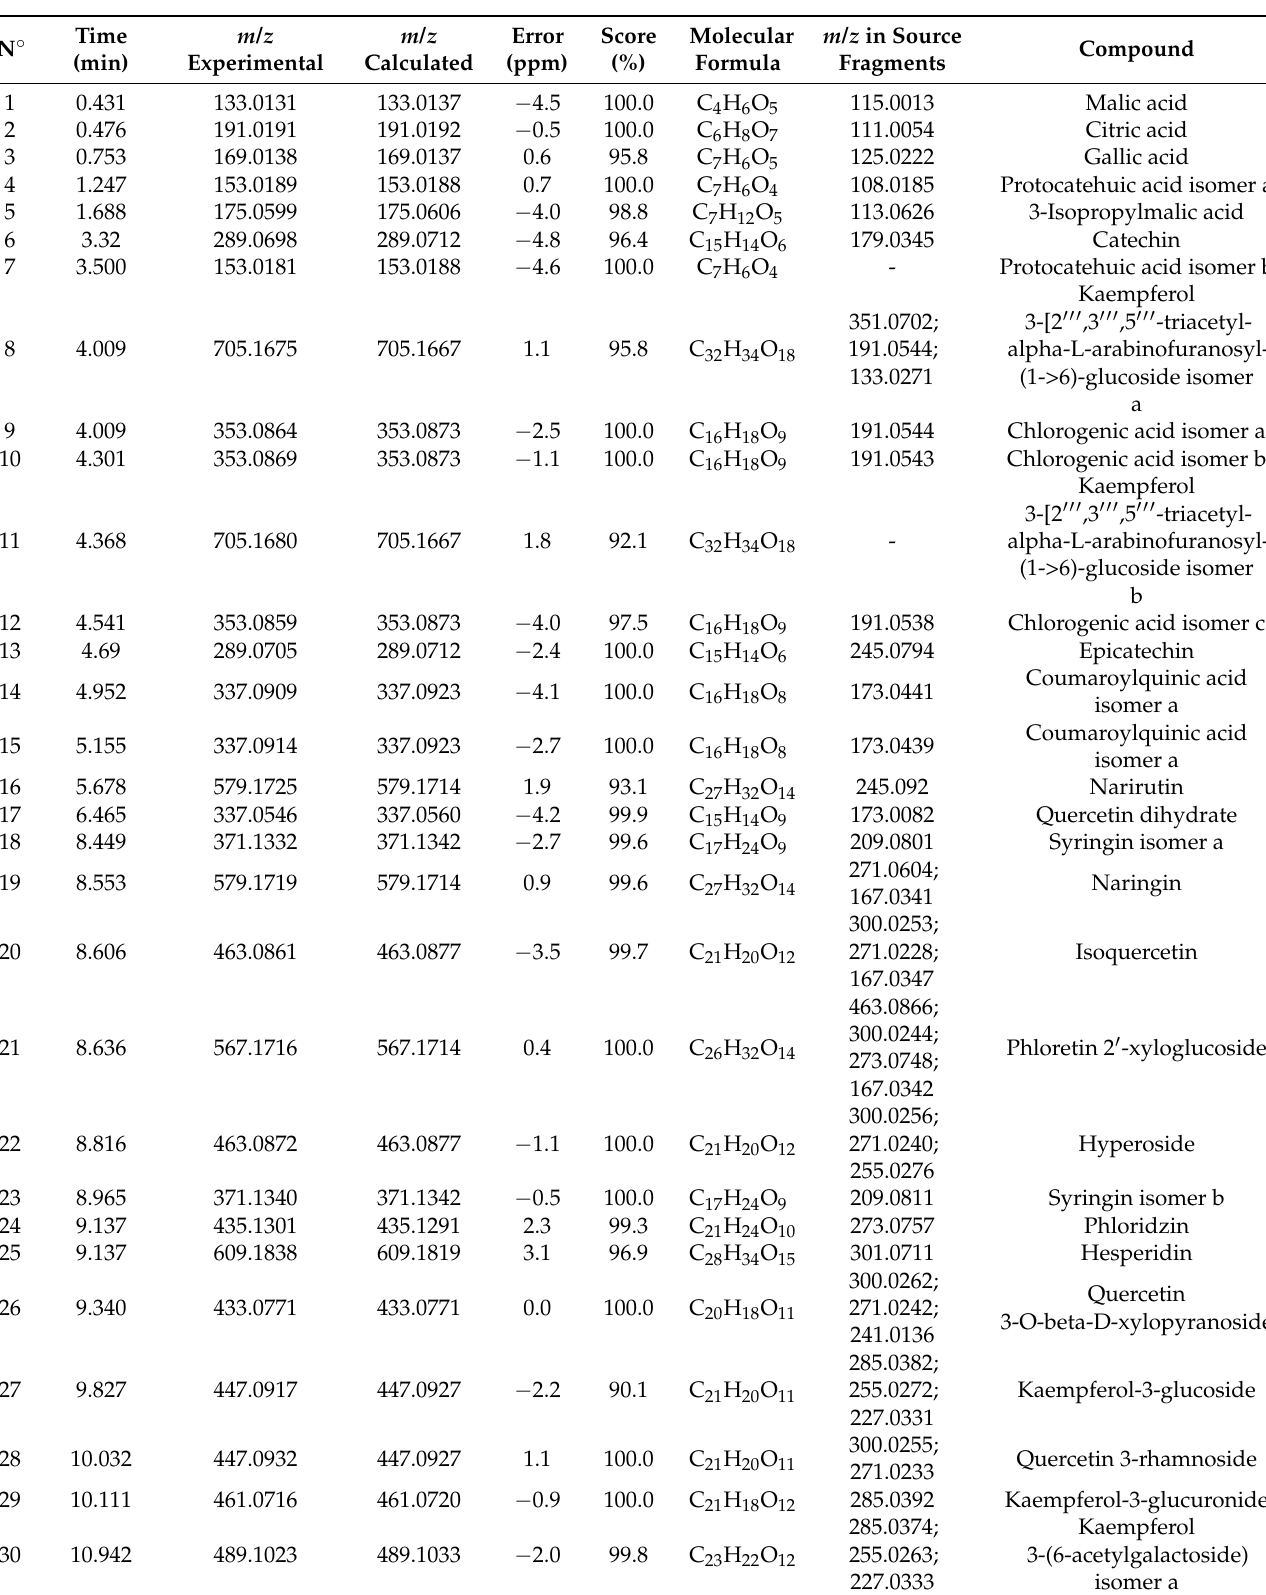
Table 2. Identified compounds in the analyzed smoothies by